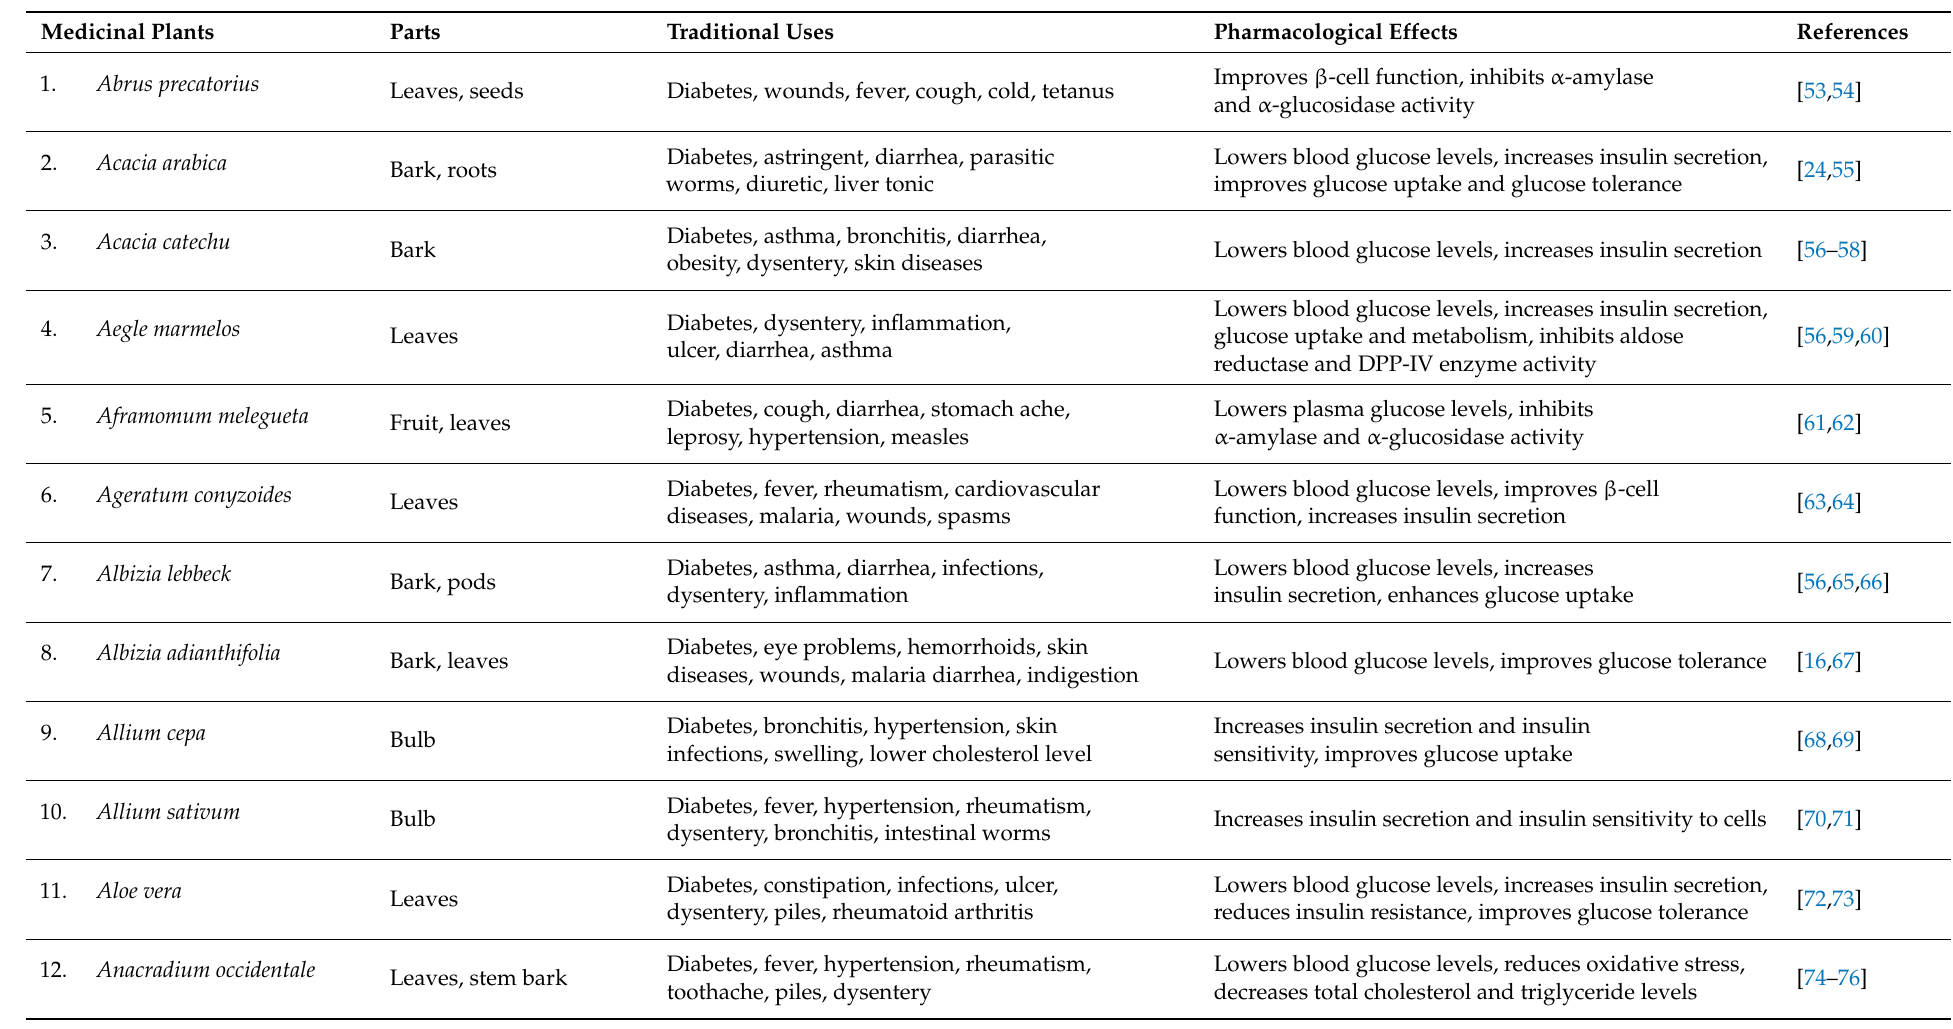
Table 1. Traditional uses and pharmacological effects of antidiabetic medicinal